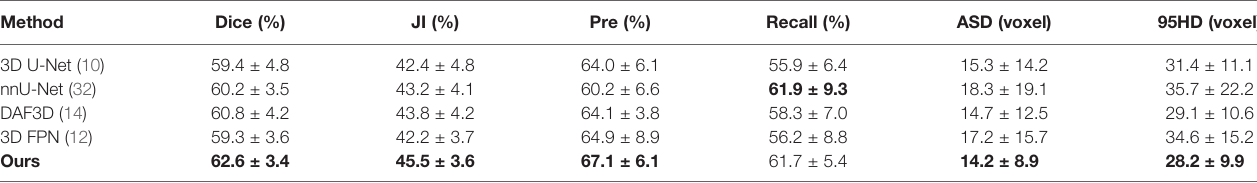
TABLE 1 | Automatic segmentation results of different methods.